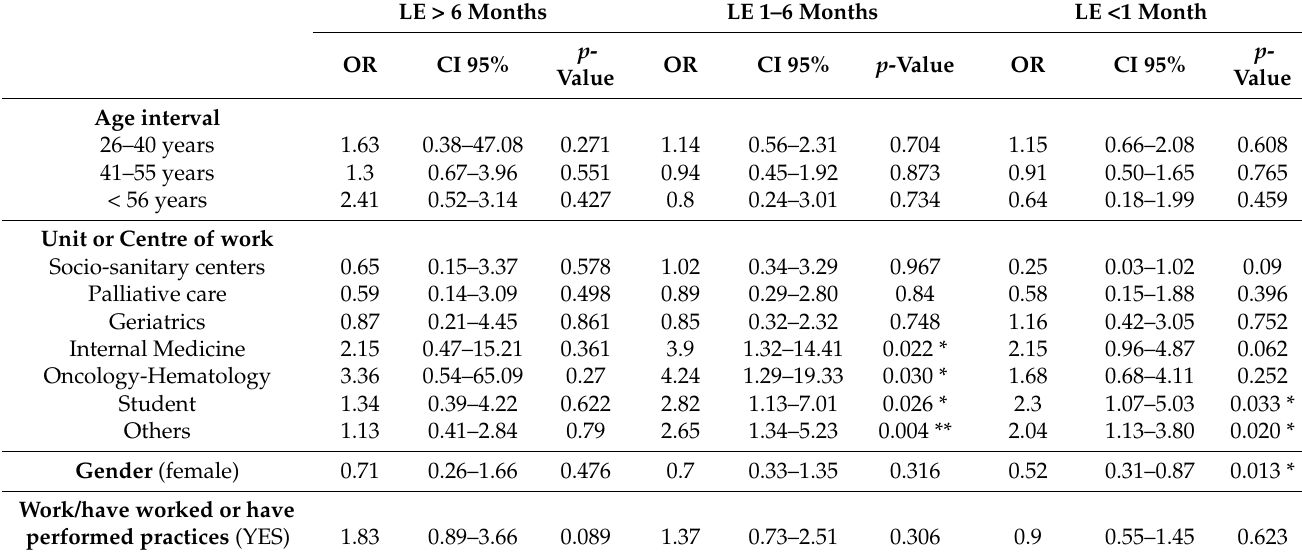
Table 3. Odds Ratio